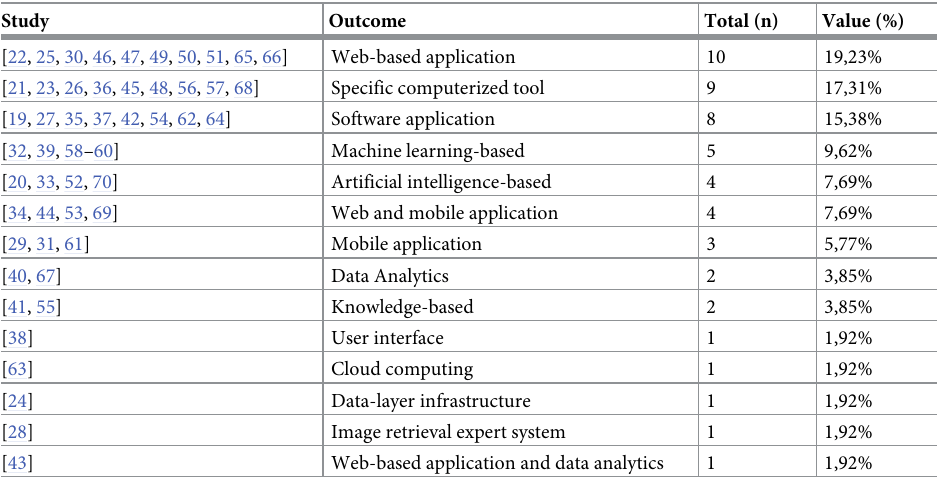
Table 6. Outcomes of type of system.